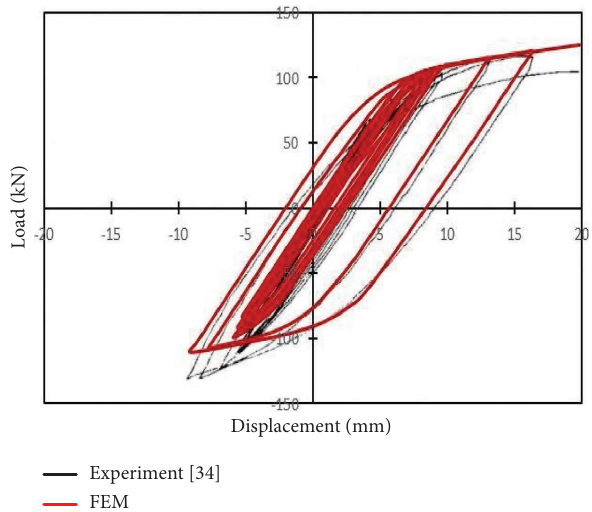
Figure 5: Load versus displacement of the experimental study and FEM model [34].